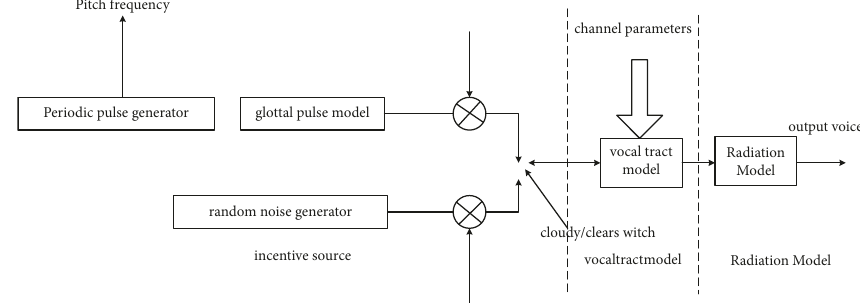
Figure 5: time domain model of speech signal generation.